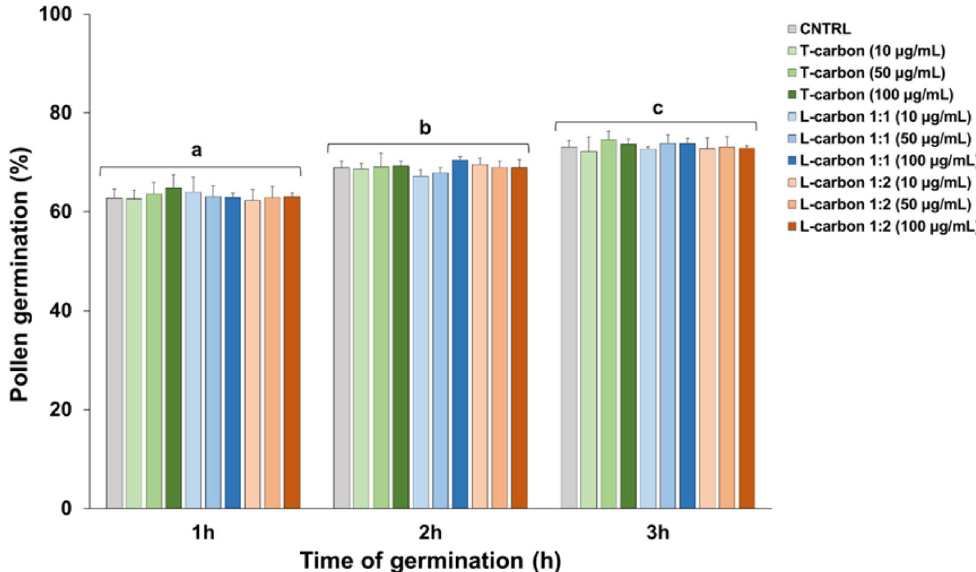
Figure 9. Effects of increasing concentrations (10–50-100 µg/mL of BK suc ) of CNS on the germination of pollen grains from N. tabacum . The measurements are relative to the control (CNTRL) and comprise a total treatment time of 3 h. The values are reported as means ± standard deviation (n = 150). A two-way ANOVA was conducted to examine the effect of time and different CNS concentration on pollen germination. There was a statistically significant interaction of time on germination, F (2, 60) = 252.460, p = 0.000. Different letters denote statistically significant changes among groups at the two-way ANOVA followed by Tukey’s post-hoc